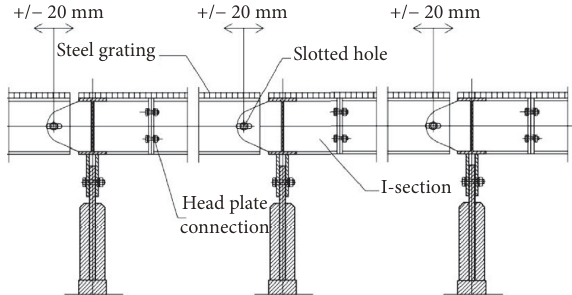
Figure 16: The detailed structure of the circular